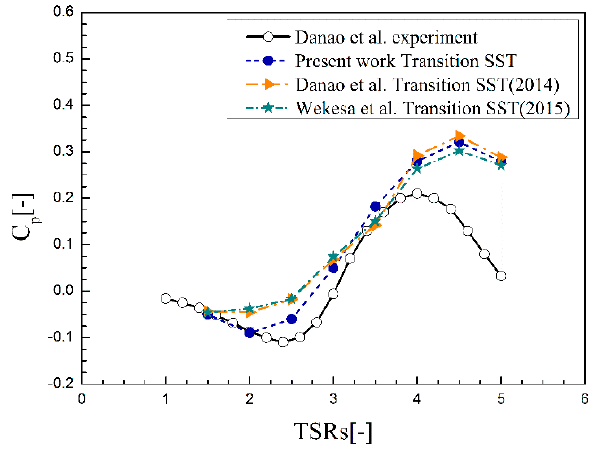
Figure 6. Comparison of numerical simulation results to experimental data and other Computational Fluid Dynamics (CFD)